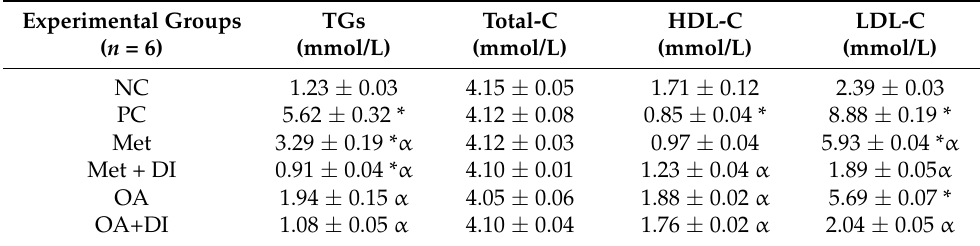
Table 2. Effects of OA and Met on the lipid profile of rats that continued with HFHC diet. Values are